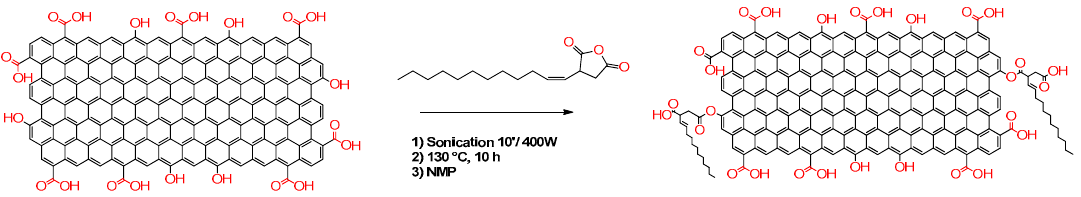
Figure 1. Functionalization of rGO with 2-(dodecen-1-yl) succinic anhydride (TPSA).